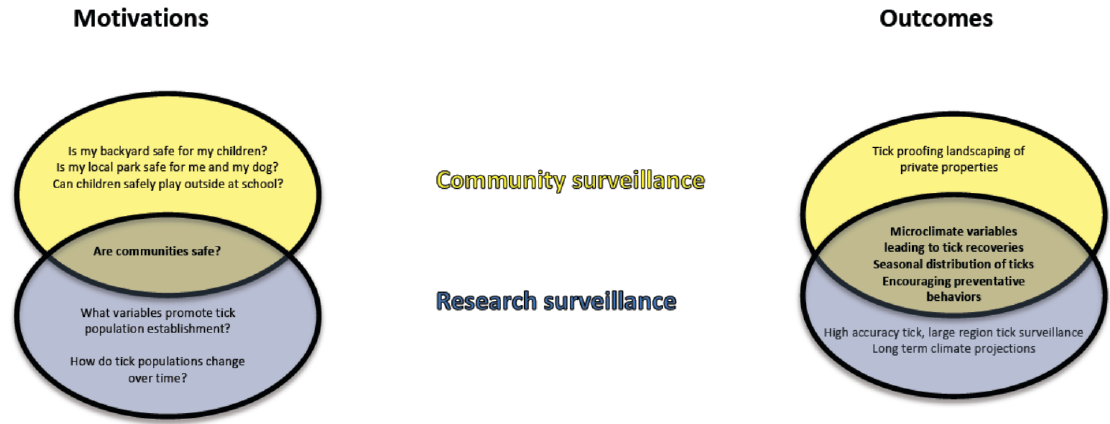
Figure 3. Overlap in motivations and outcomes of community- and research-initiated tick surveillance efforts. Community- and research-initiated efforts differ in the scale and expense of their investigation but, as both are designed to enhance community safety, research and community outcomes are highly overlapping. highly